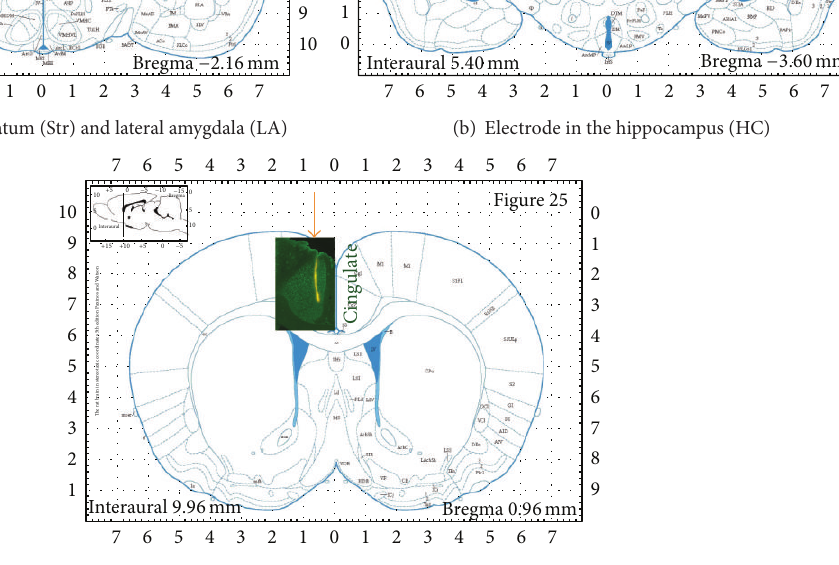
−3.60 mm Interaural 5.40 mm